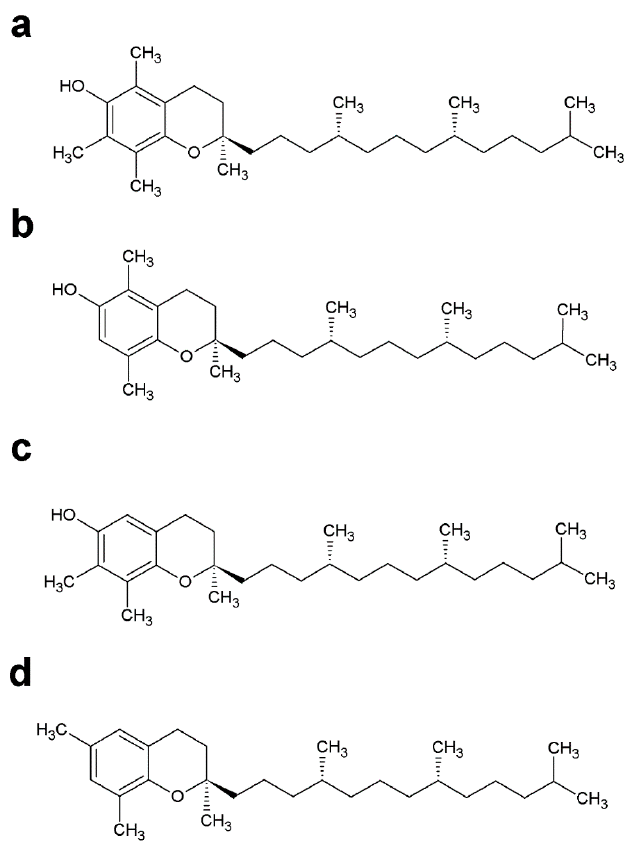
Chemical structures of tocopherols. ( a ) Chemical structures of alpha-tocopherol, ( b ) beta-tocopherol, ( c ) gamma-tocopherol and ( d ) delta-tocopherol.